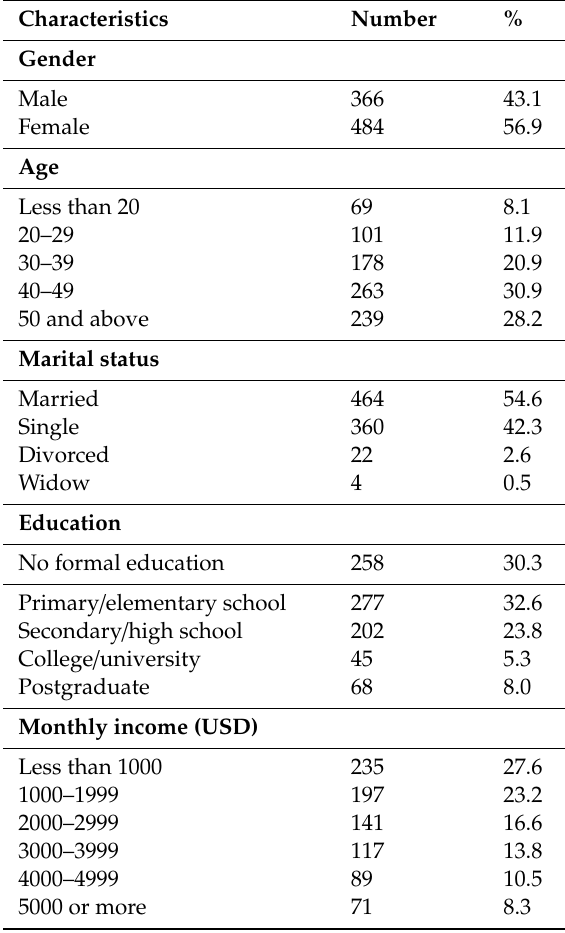
Table 1. Demographic